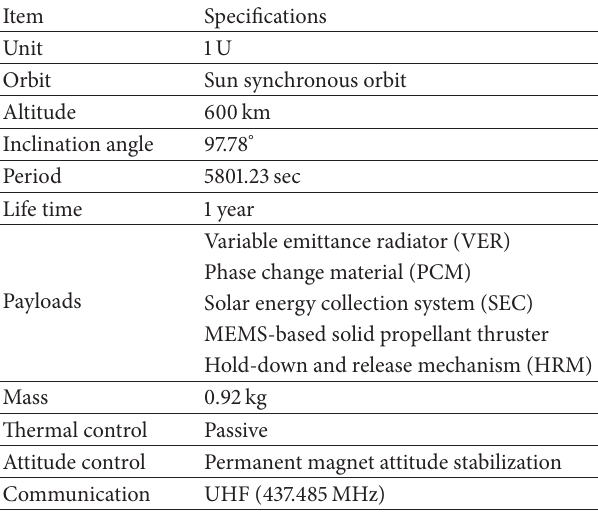
Table 1: System specification of STEP Cube